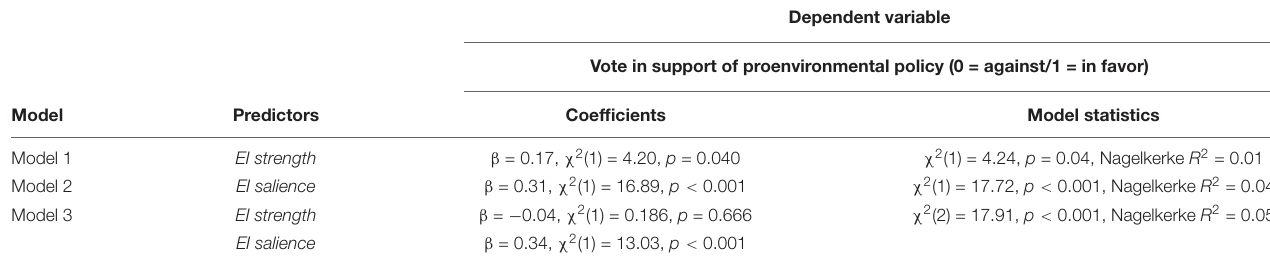
TABLE 5 | Logistic regression models (Study